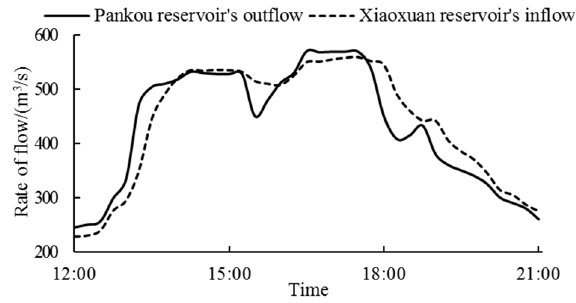
Figure 2. Pankou’s outflow and Xiaoxuan’s inflow.